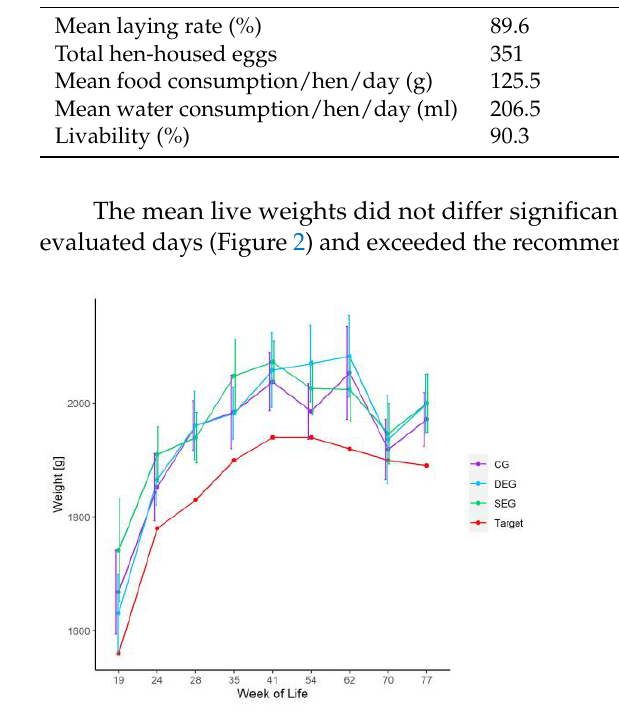
Figure 2. Mean live weights and standard deviation of the hens (Lohmann Brown Lite, Lohmann Tierzucht GmbH, Cuxhaven, Germany) in the three groups (CG = control group, SEG= single enrichment group, DEG= double enrichment group), determined via manual weighing of 30 hens per group and the target weights as recommended by the breeder [30] during the husbandry period (weeks of life 19 – 77).